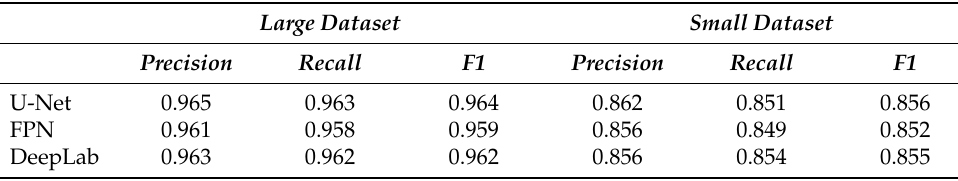
Figure 5. Input image from new region outside training site, Zelenodolsky District, Republic of Tatarstan, Russia, 55°55 (cid:48) 48.0 (cid:48)(cid:48) N 48°44 (cid:48) 24.0 (cid:48)(cid:48) E (composite orthophotomap provided by Mapbox, ac- quisition date: 20 March 2022) ( a ); Open Street Map (acquisition date: 20 March 2022) ( b ); forest segmentation results of the final CNN model fine-tuned with OBA ( c ). Table 1. Forest segmentation results for baseline model on two